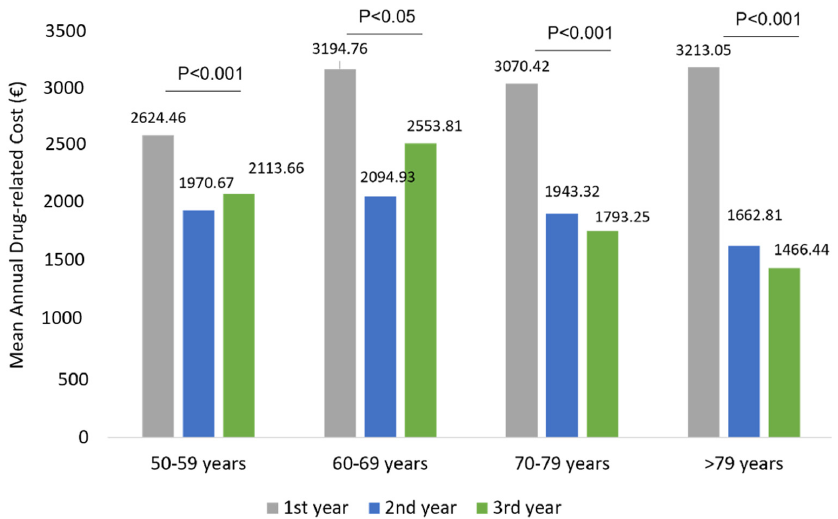
Figure 7. Drug-related costs during the follow-up among patients of other ocular disease patients stratified by age